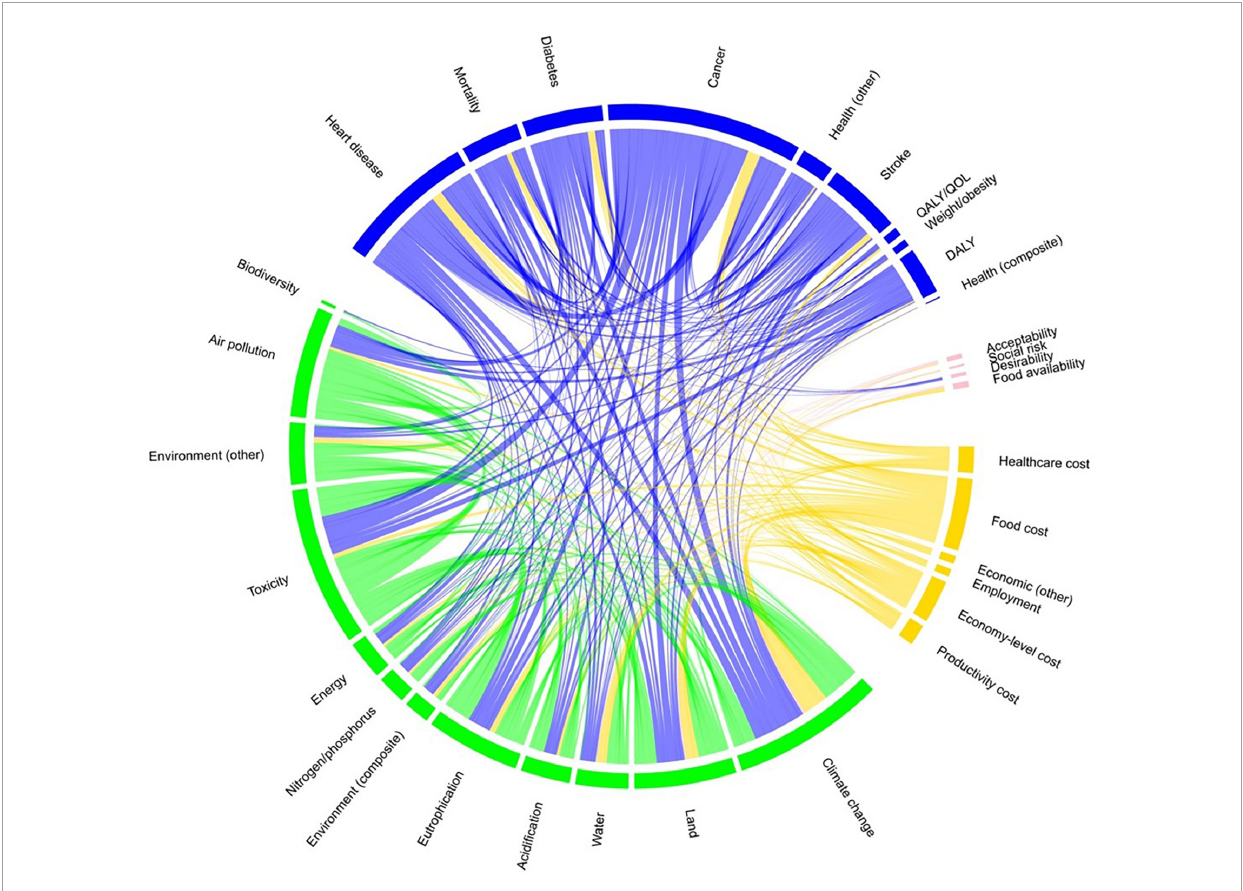
FIGURE3 Chord diagram of